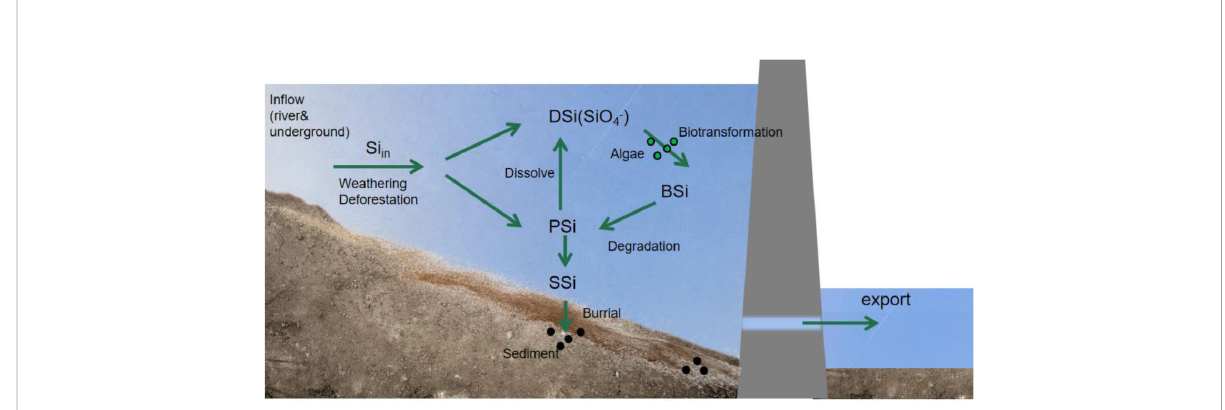
FIGURE 3 Circulation process of silicon in a reservoir. DSi, dissolved reactive silicon; SSi, sediment silicon; PSi, particulate reactive silicon; BSi, biogenic